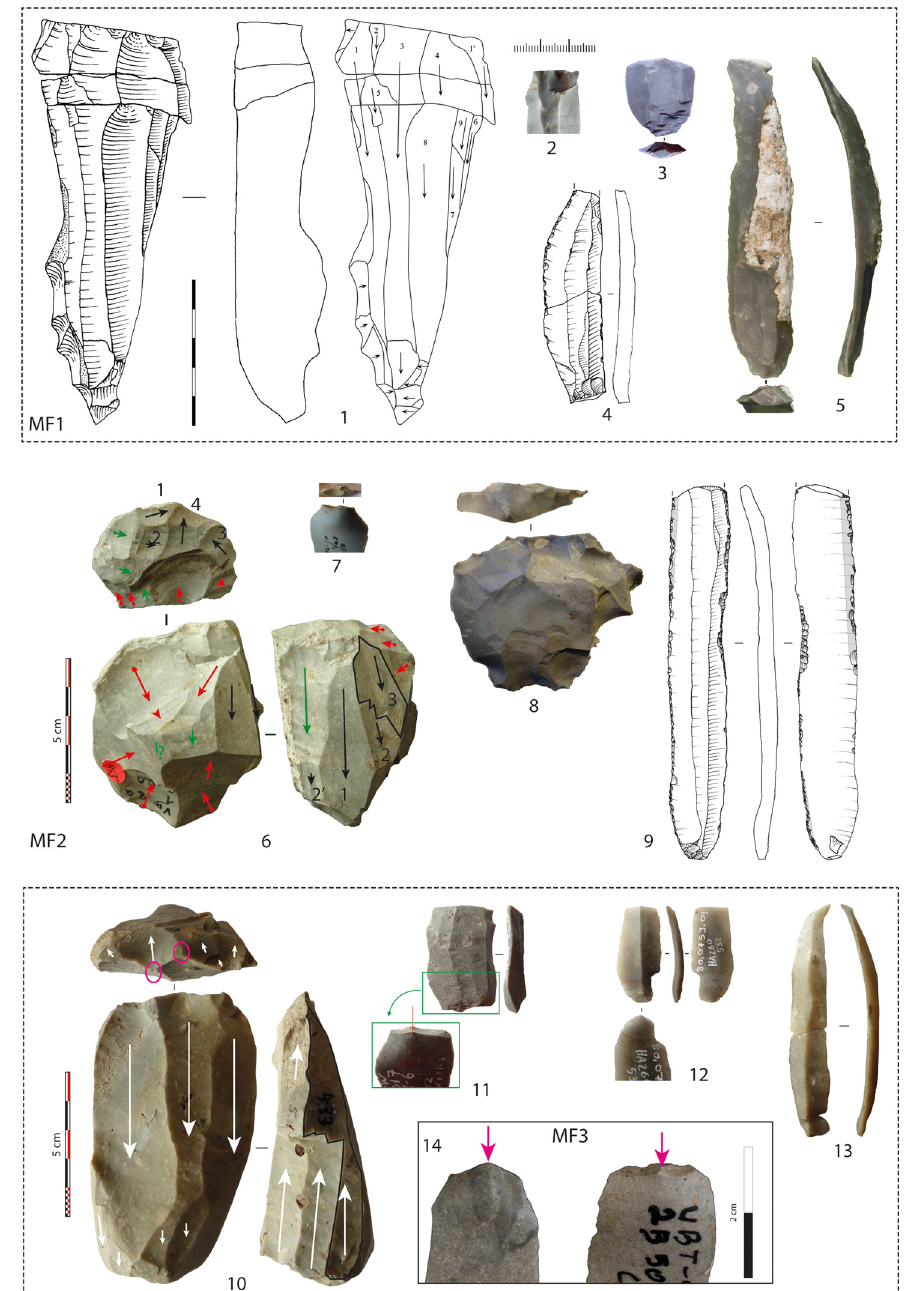
Figure 5: Illustrations of the technical characteristics of the three most important technical groups identi fi ed. MF1 ( nos. 1 – 5 ) ; MF2 ( nos. 6 – 9 ) ; MF3 ( nos. 10 – 13 ) . 1: Core in Campanian fl int from Hesbaye, Verlaine settlement, structure 01 (